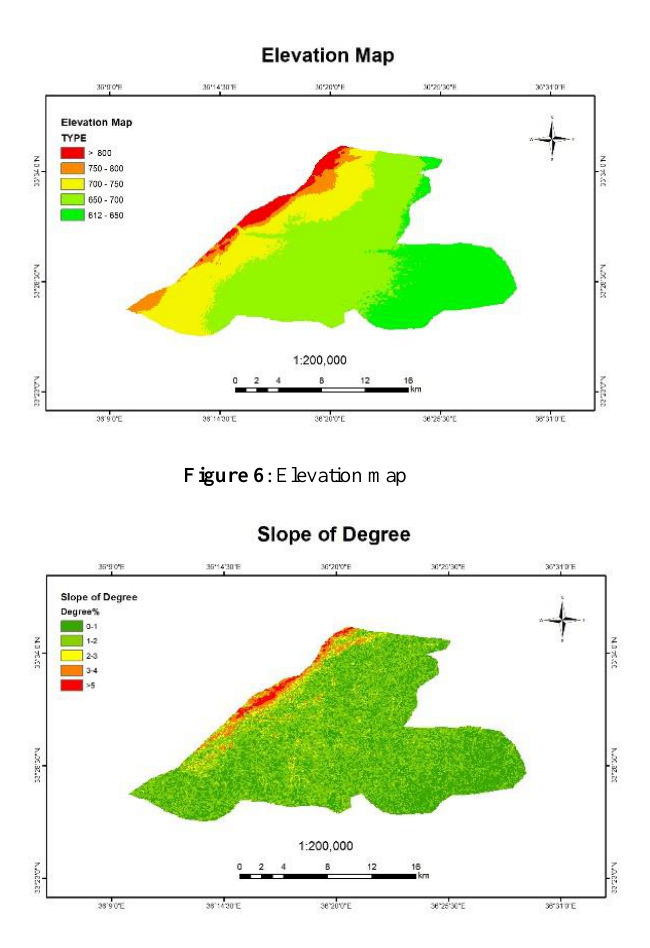
Figure 7 : Slope of